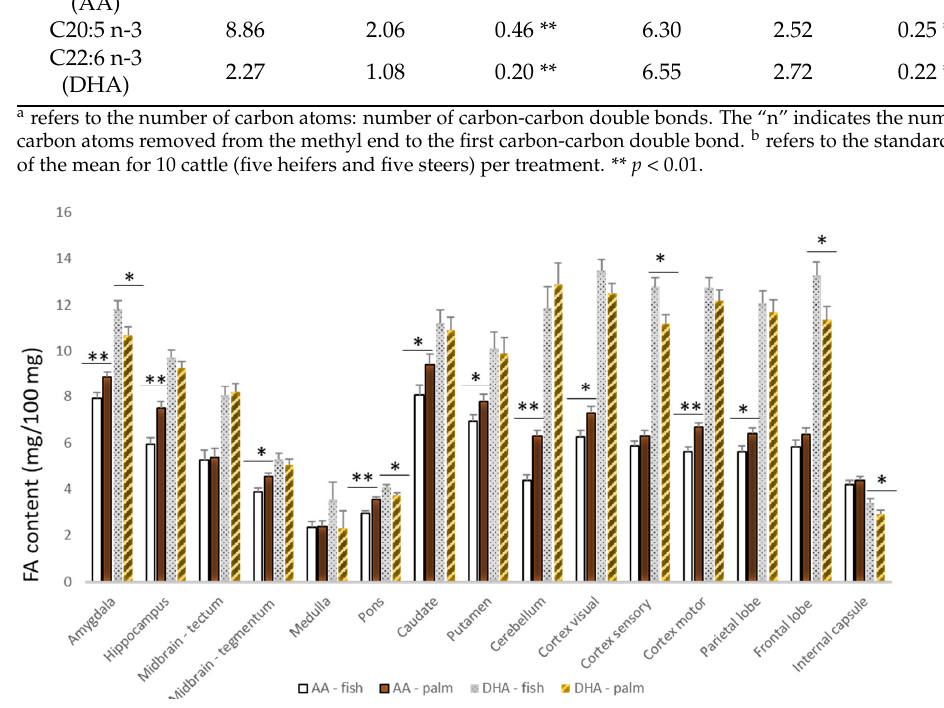
Figure 1. Content (mg/100 mg) of arachidonic acid (AA) and DHA across the brain regions of the cattle supplemented with the calcium salts of fish or palm oil (* p ≤ 0.05; ** p ≤ 0.01). The fatty acids C18:1 n-7 (vaccenic), C20:1 n-9 (eicosenoic), C22:4 n-6 (adrenic), and C22:5 n-3 (docosapentaenoate) all occurred in the brains of the cattle at